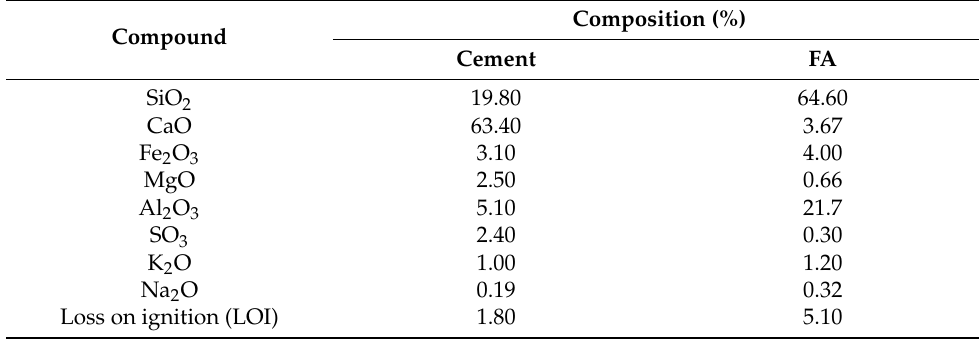
Table 2. Chemical compositions and LOI of cement and FA.